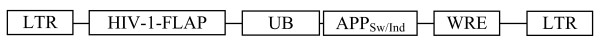
DNA construct of pLVU-APPSw/Ind. LTR: long terminal repeat; UB: ubiquitin-C promoter; APP: human amyloid precursor protein; WRE: woodchuck hepatitis virus post-transcriptional regulatory element.